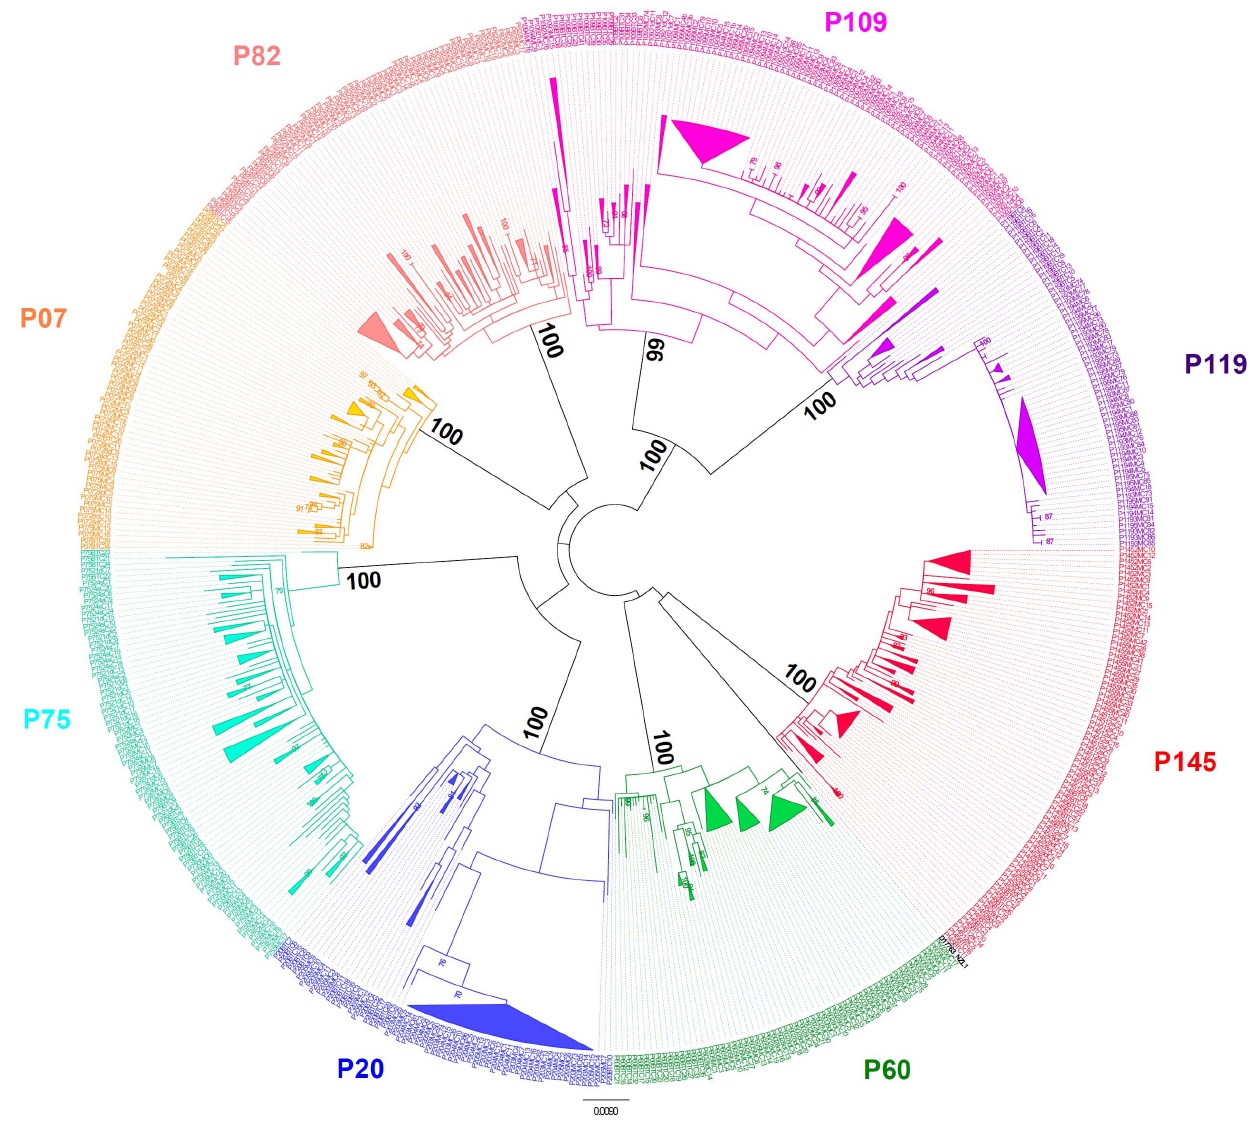
Figure 8. Phylogenetic tree. Unrooted Maximum-Likelihood phylogenetic tree was constructed with HKY85 substitution model including Gamma distribution parameter (HKY + G). Bootstrap was performed with 500 replicates. Values above 70% were considered significant.